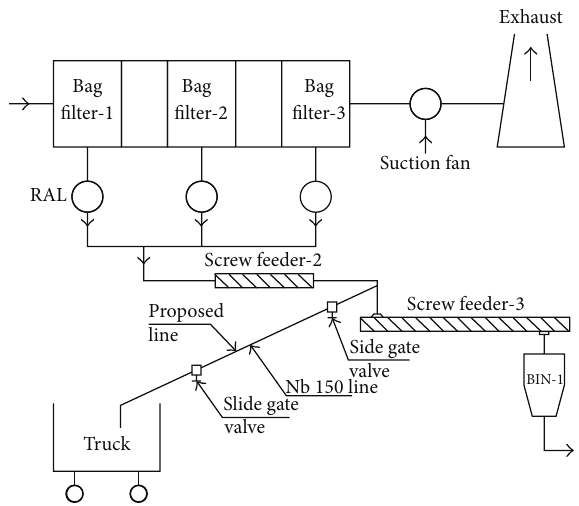
Figure 10: Lime mill arrangement for segregation of lime powder particles less than 50 microns.